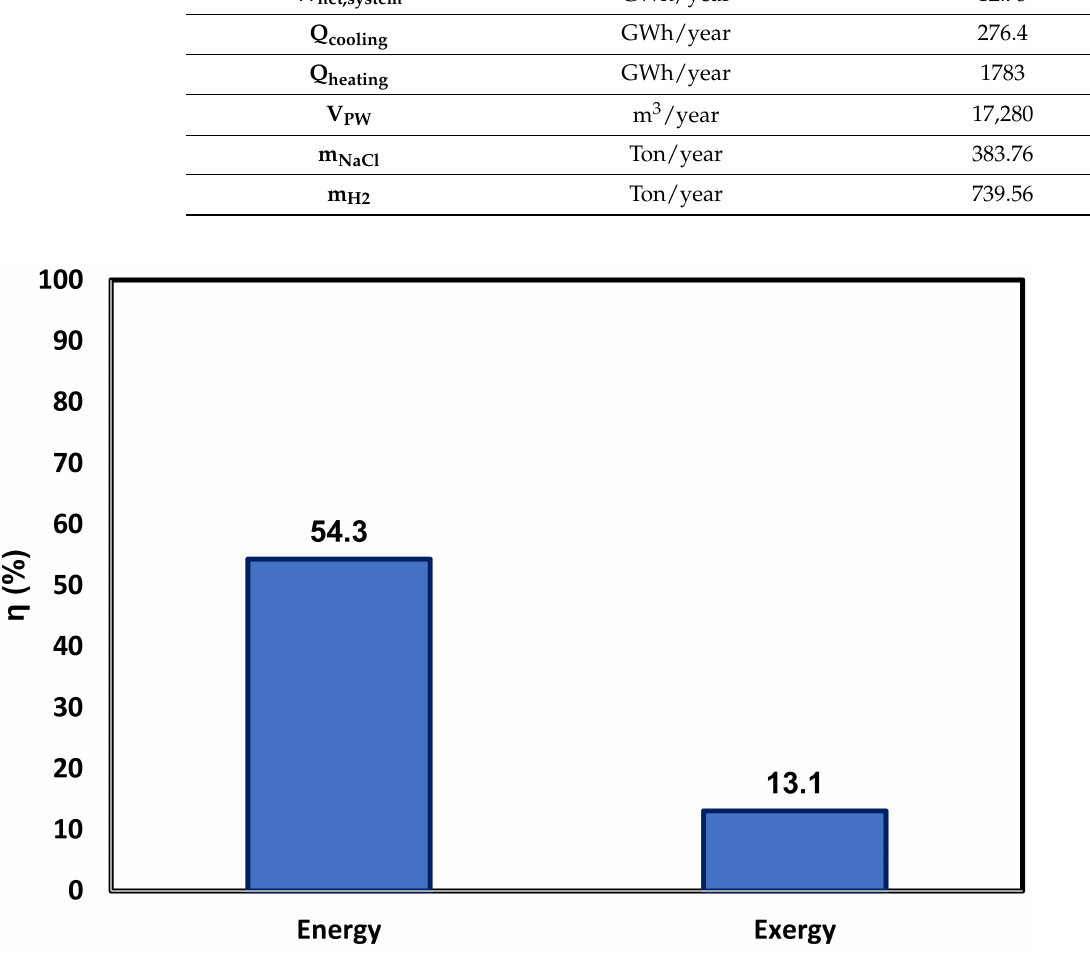
Figure 4. The system energy and exergy